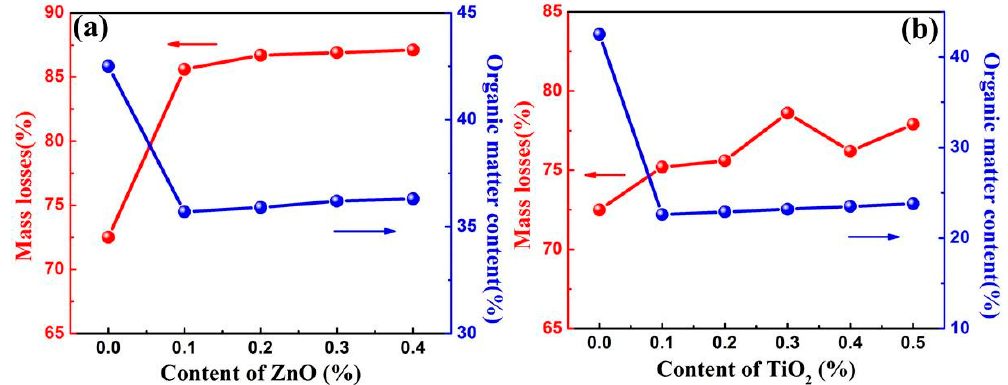
Figure 3. Relationship of mass losses and organic matter content with the content of ZnO ( a ) and TiO 2 powder ( b ).